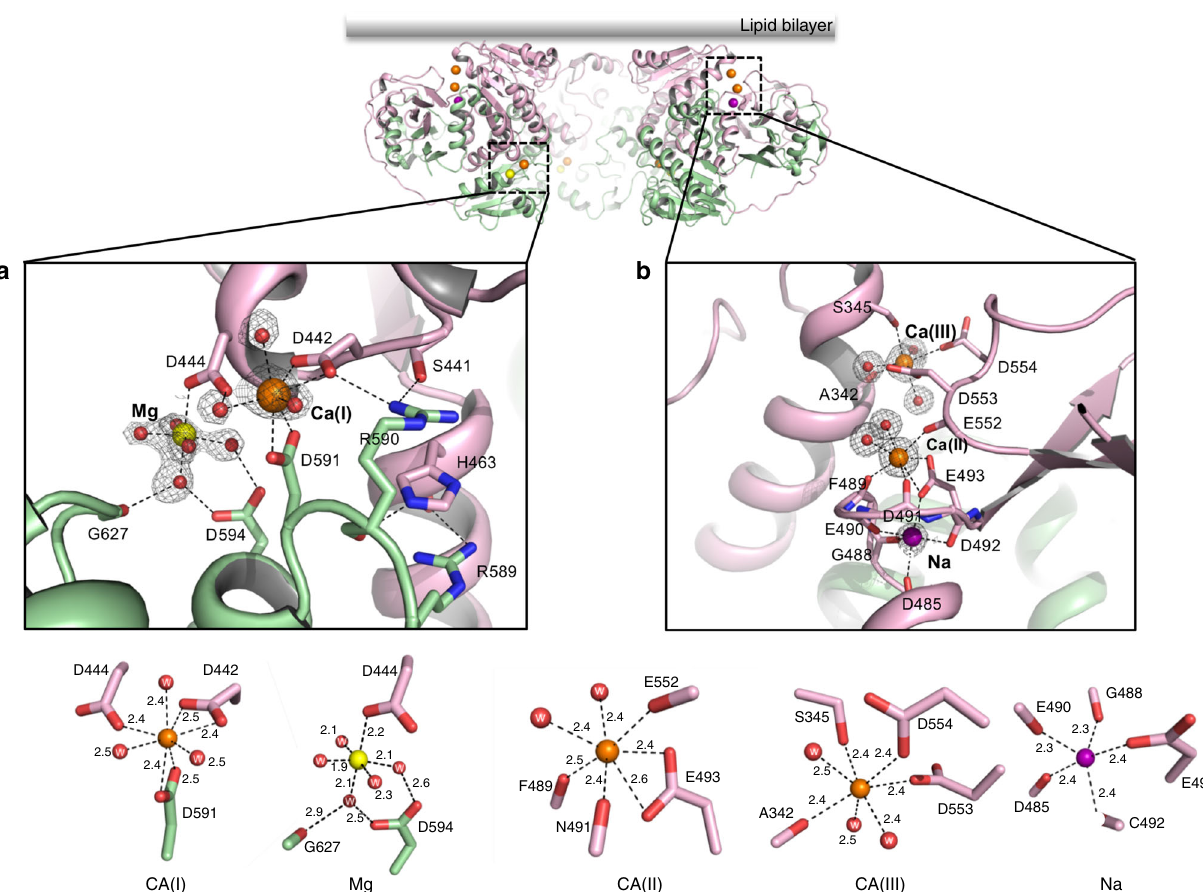
Fig. 4 The locations and structure details of the two clusters of ion-binding sites within each LjCASTOR subunit. a Structure of the cluster I ion-binding sites (top panel) with detailed ion coordination distances (bottom panel). b Structure of the cluster II ion-binding sites (top panel) with detailed ion coordination distances (bottom panel). The electron density (gray mesh contoured at 1.5 σ ) of ions and water molecule is calculated from the 2Fo-Fc context of gating ring, however, there is no signi fi cant change in the ring size of CASTOR with or without Ca 2 + . As shown in Fig. 6a, the two diagonal distances of the asymmetrical apo ring (between the C α of Thr 323) are about 61 and 66 Å, respectively, whereas the equivalent distance is 62 Å in the symmetrical Ca 2 + - bound gating ring (Fig. 6b). This fi nding is different from BK or MthK channels in which Ca 2 + ligand induces a signi fi cant expansion of the gating ring. In light of the low single-channel, open probability of CASTOR with Ca 2 + activation as well as the inhibition of channel by Ca 2 + at sub-millimolar concentrations, the structures of the CASTOR gating rings in the apo and Ca 2 + - bound states both likely represent the closed conformation.